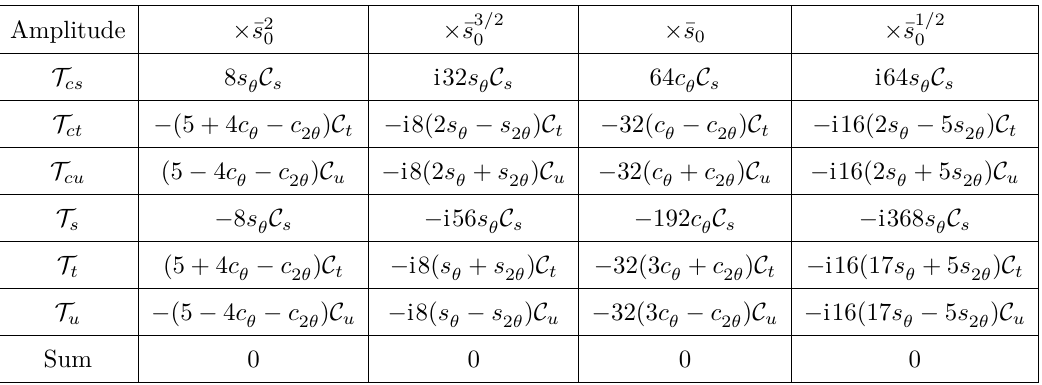
Table 4 . Energy cancellations in the 4-gauge boson scattering amplitude of 3d non-Abelian TMYM theory, T [ A a A b → A c A d ] = T + T s + T t + T u , where the amplitude from contact diagram is further c P P P P decomposed into three sub-amplitudes according to their color factors, T c = T cs + T ct + T cu . The energy factor is defined as ¯ s = 4 ¯ E 2 β 2 and ¯ E = E/m . A common overall factor ( g 2 / 128) in each 0 amplitude is not displayed for